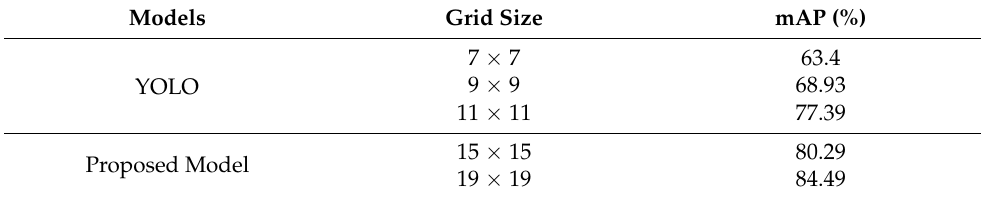
Table 4. Comparison of mAP on various grid sizes.